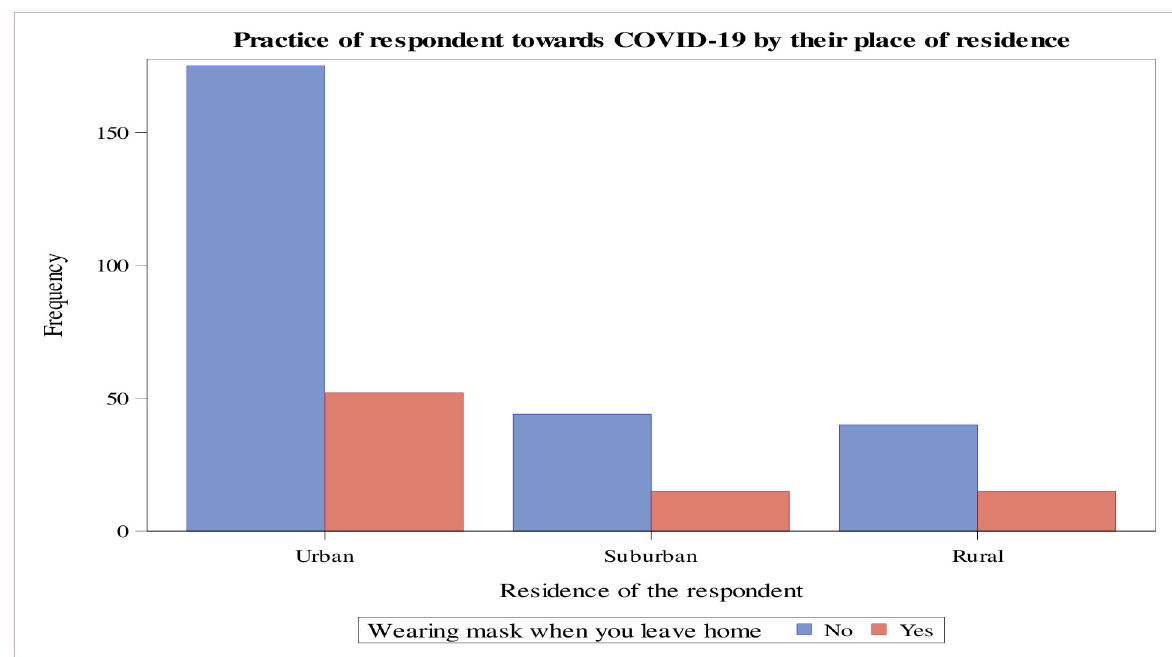
Fig 4. Respondents’ practice of wearing masks in public places by their place of residence, Ethiopia, May 2020.